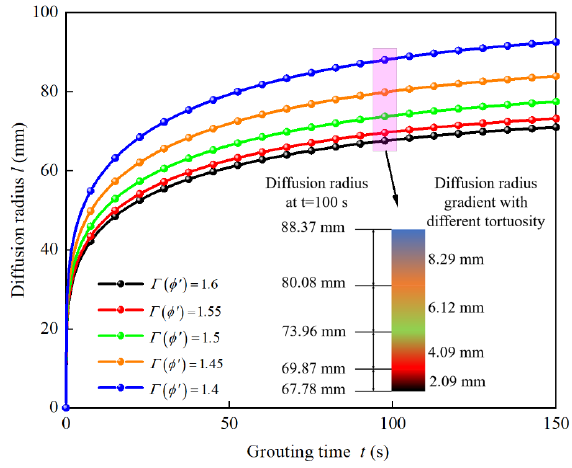
Figure 8. Influence of tortuosity on the slurry diffusion radius.